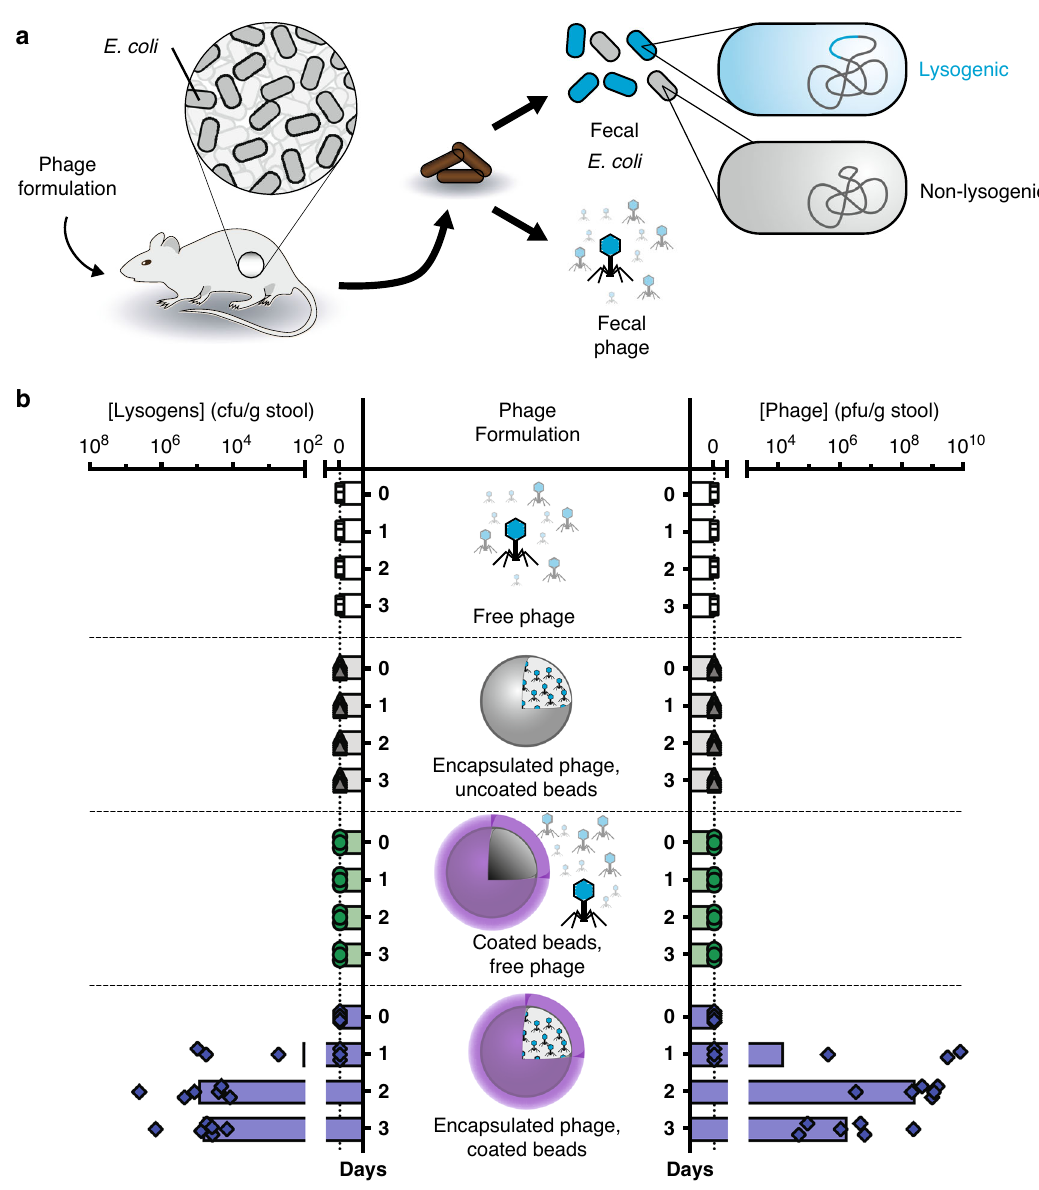
Fig. 5 Ef fi cacy of oral encapsulation formulation on bacteriophage survival in mice. Mice pre-colonized with E. coli were orally administered phage formulations ( a ). Mice were administered either free phage ( n = 5), phage encapsulated in uncoated beads ( n = 6), a mixture of free phage with empty Layer-by-Layer (LbL)-coated beads ( n = 3), or phage encapsulated in LbL-coated beads ( n = 6). “ LbL-coated ” indicates coatings of (polyethylenimine/ pectin) 15.5 fi lms. Fecal concentrations of lysogens and phage were quanti fi ed over time ( b ). Symbols represent individual mice with bars indicating geometric mean. Source data are provided as a Source Data fi